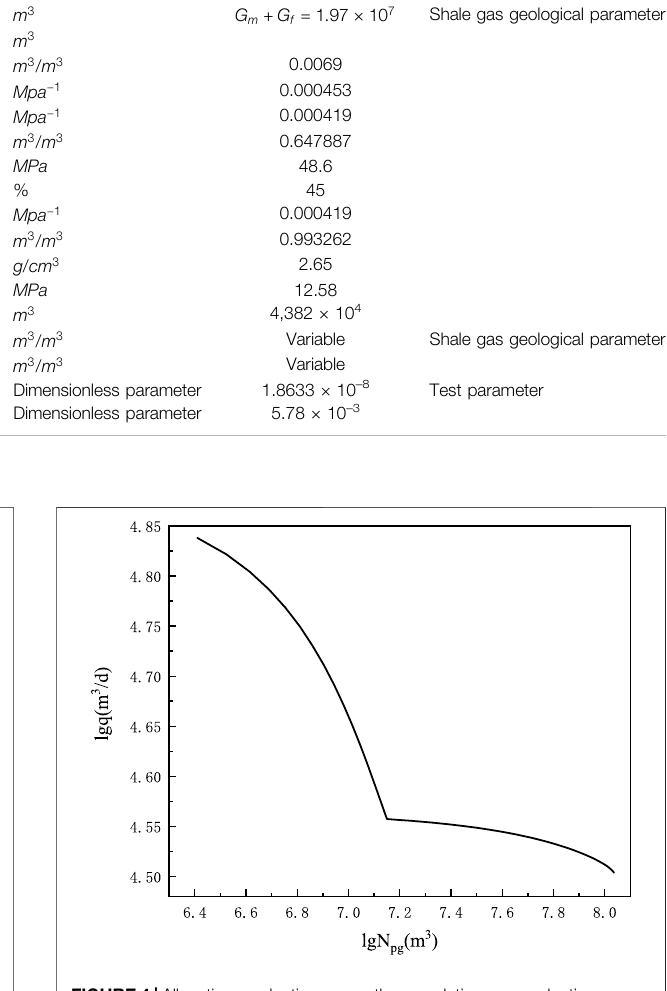
FIGURE 3 | Formation pressure versus the cumulative gas production double logarithm chart of Well #1 shale gas Block XX.